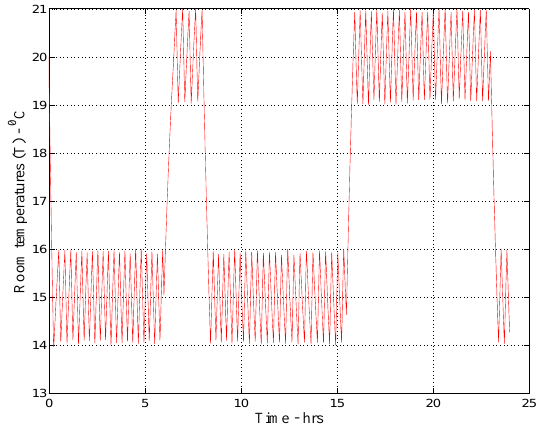
Figure 8: Temperature variations inside the large building